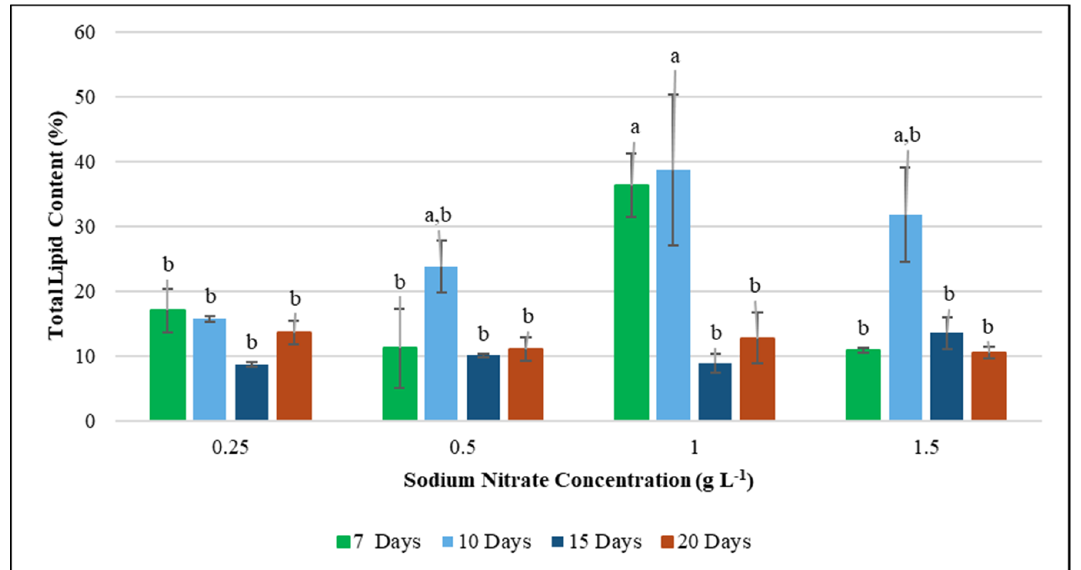
Figure 2. Effect of total lipid production in Fremyella diplosiphon grown in nitrogen concentrations of 0.25, 0.5, 1.0, and 1.5 g L − 1 sodium nitrate over a period of 7, 10, 15, and 20 days. The average % lipid content of total cellular dry weight (± standard error) for three biological replicates of each treatment is shown. Different letters above bars indicate significance among treatment means ( p < 0.05).